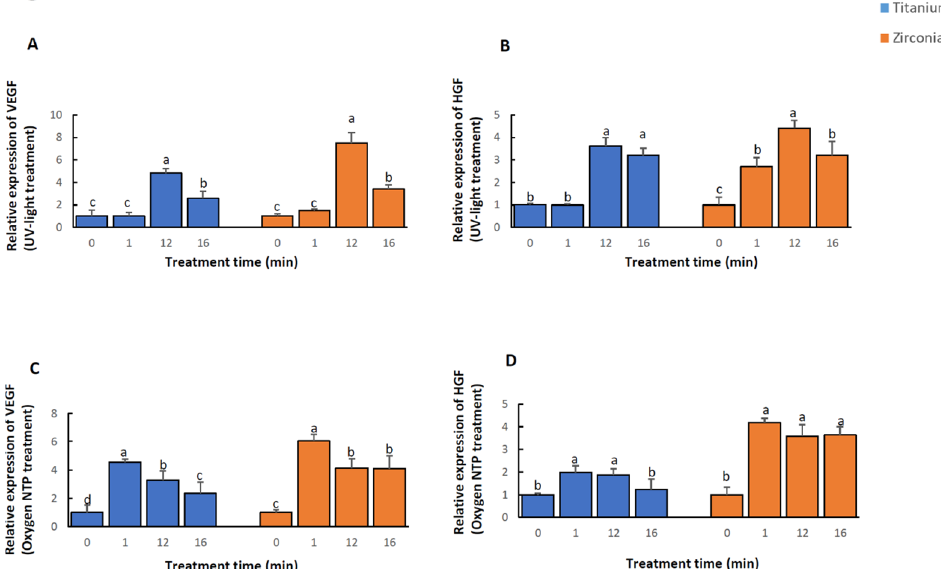
Figure 2. The relative gene vascular endothelial growth factor (VEGF) and hepatocyte growth factor (HGF) expressions of MC3T3-E1 after 24 h of culture following time-course surface treatment of titanium and zirconia with UV-light ( A , B ) and oxygen NTP ( C , D ). Each letter on top of each bar indicates the order of relative gene expression, where the letter a indicates the test or control group with the highest relative gene expression. The same letter indicates no statistically significant difference in relative gene expression between the groups. All of the statistical significance values were declared as p < 0.05.